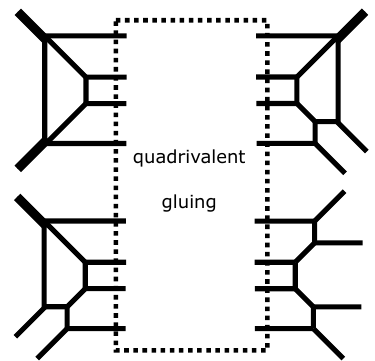
Figure 31. The web diagram for 5d G 2 gauge theory with 4